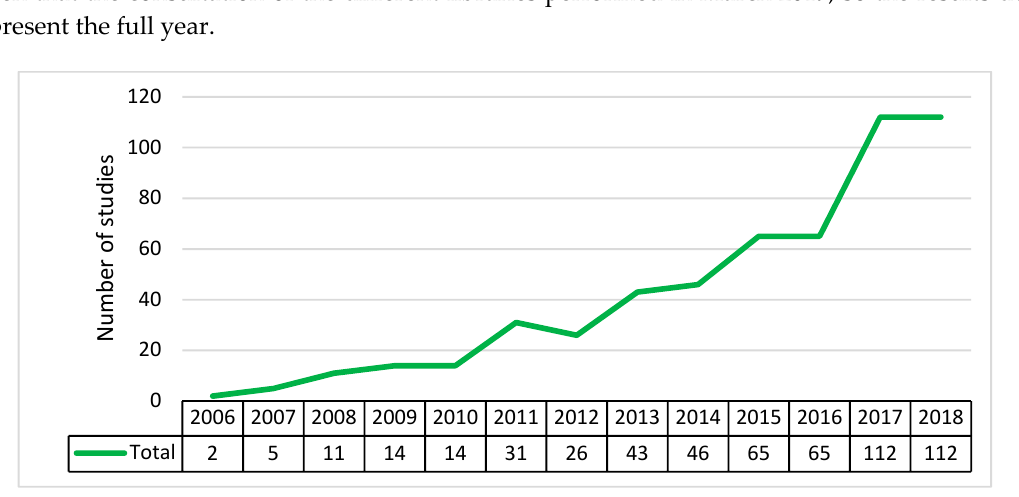
Figure 2. Total uses of standardized questionnaires by year, summarizing all three